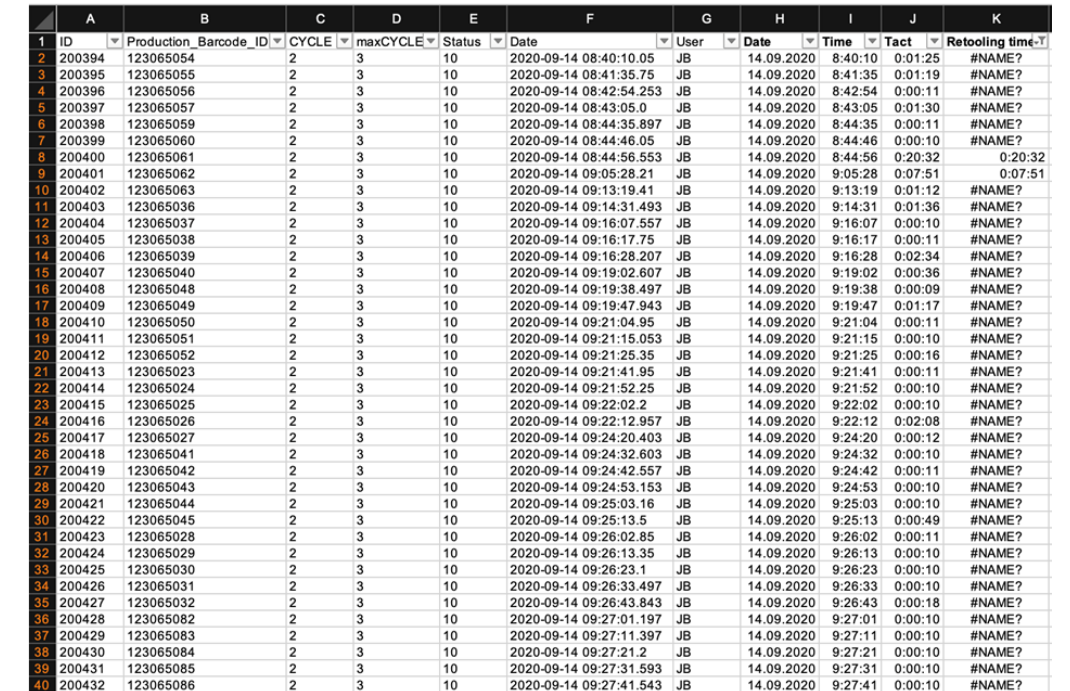
Figure 3. An example of the machine report.